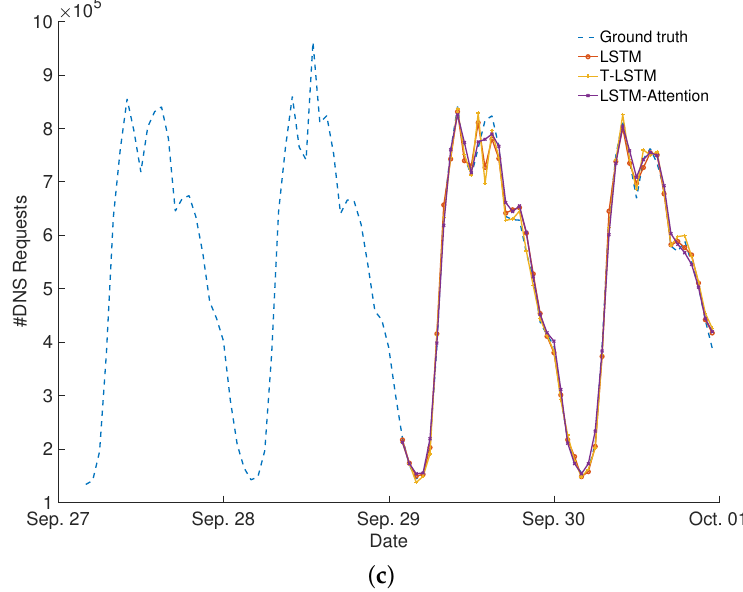
Figure 7. ( a ) Prediction results using deep learning models on the Alibaba Cloud dataset. ( b ) Prediction results using deep learning models on the Tencent Cloud dataset. ( c ) Prediction results using deep learning models on the 13 CDN service providers